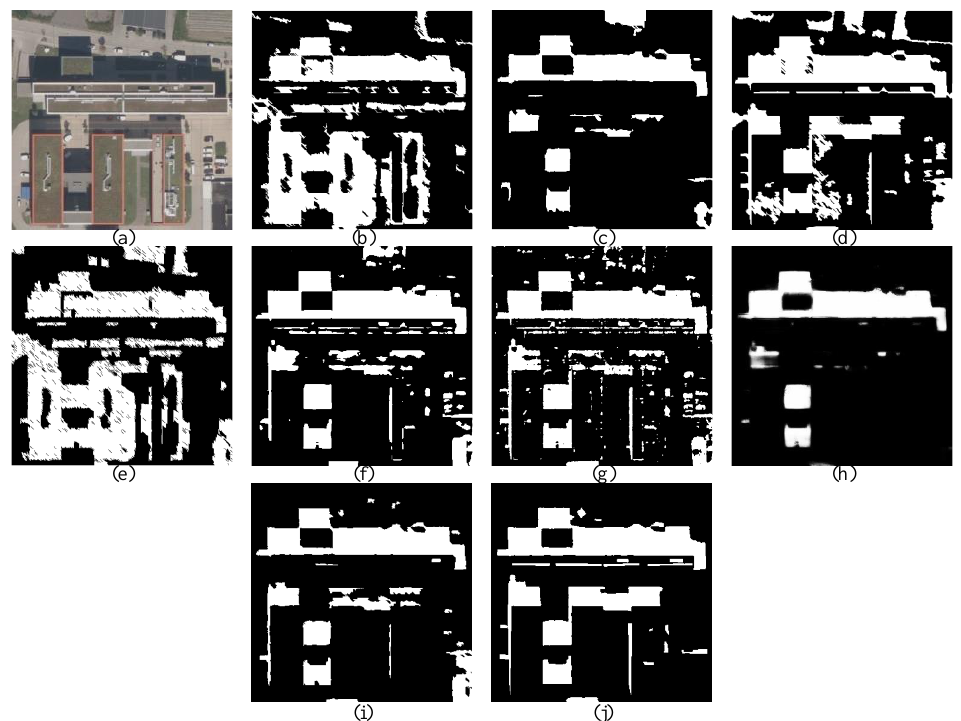
Figure 7. ( a ) Original image; ( b ) SRHI; ( c ) NB; ( d ) HTD; ( e ) C1C2C3; ( f ) U-Net method; ( g ) Segnet method; ( h ) BDRAR method; ( i ) DLA-PSO method; ( j ) ground truth. Table 4. Innsbruck shadow-test-evaluation index. SRHI NB HTD C1C2C3 U-Net Segnet BDRAR DLA-PSO